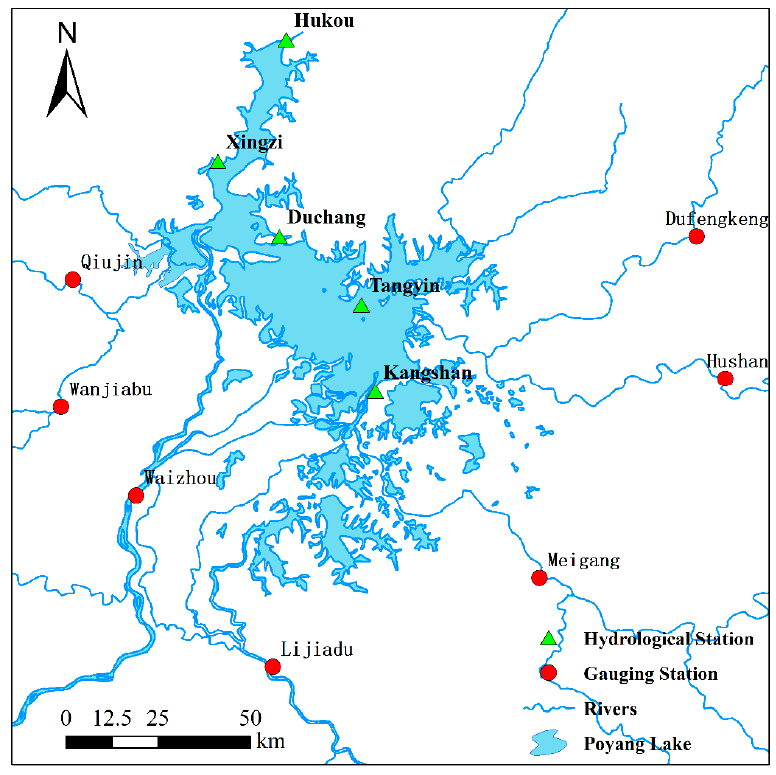
Figure 1. Geographical locations of the five hydrological stations in Poyang Lake. Table 1. Basic information on the remote sensing images of Poyang Lake,